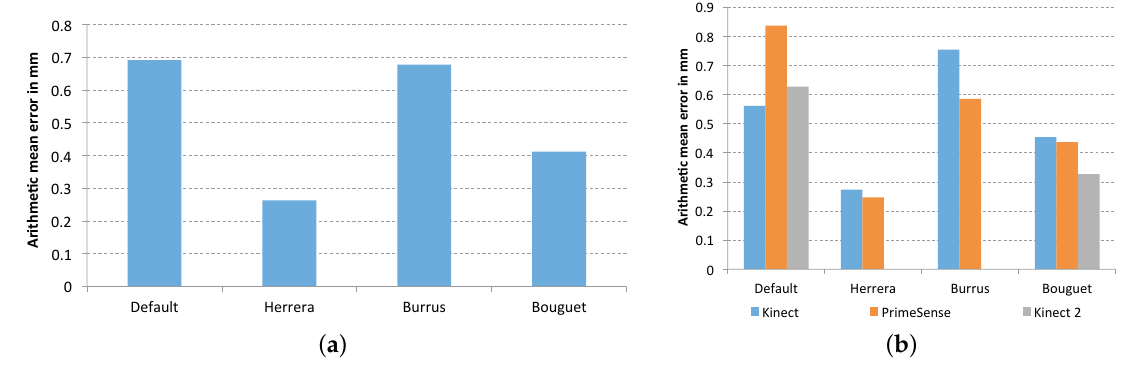
Figure 15. Accuracy of the measurements. ( a ) Error of each method; ( b ) Error of each sensor group by